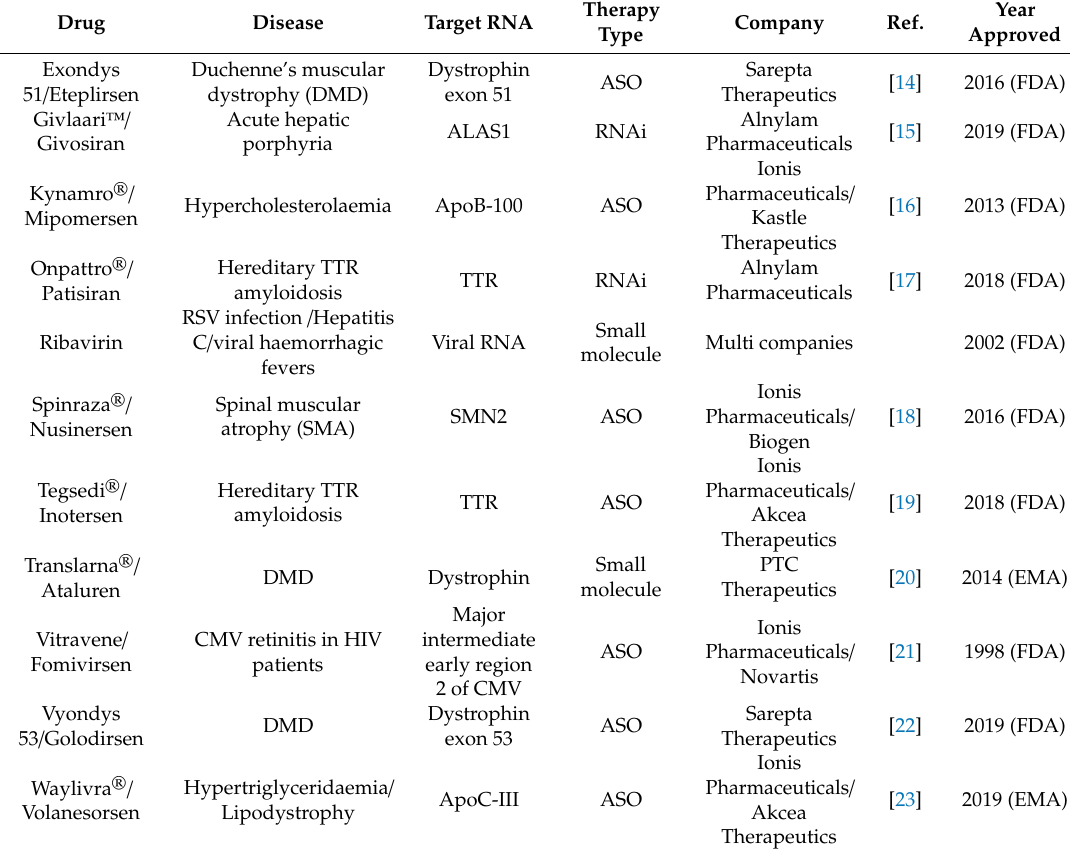
Table 1. Marketed RNA-targeted